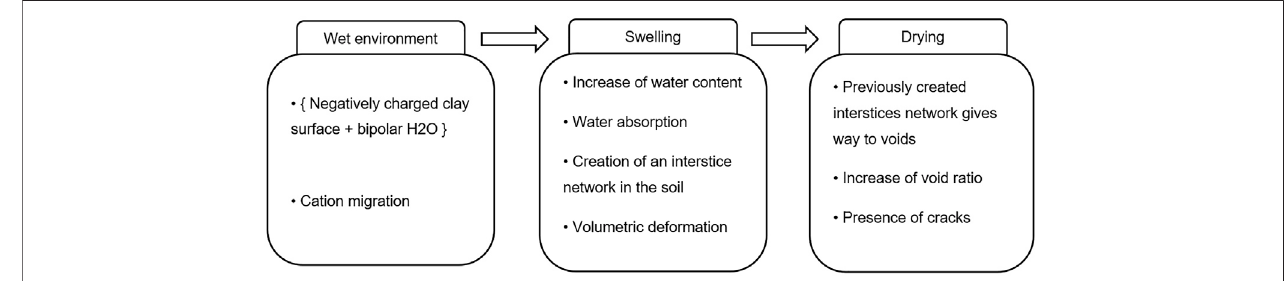
FIGURE 4 | Summary of shrink-swell phenomenon.